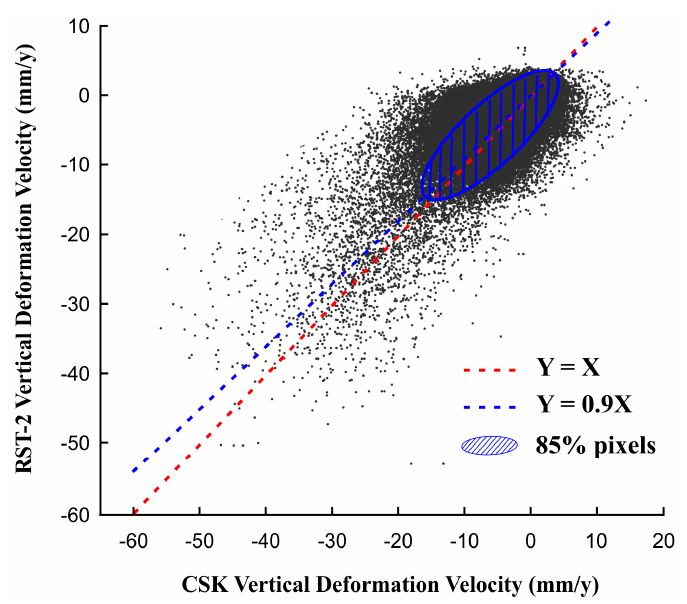
Figure 6. The comparison of CSK and RST-2 vertical deformation velocities at common coherent pixels. The blue line represents the linear fitting model by considering the 85% shared high-coherent pixels limited to the blue ellipse. The X axis stands for the CSK vertical deformation velocities, and the Y axis stands for the RST-2 vertical deformation velocities.